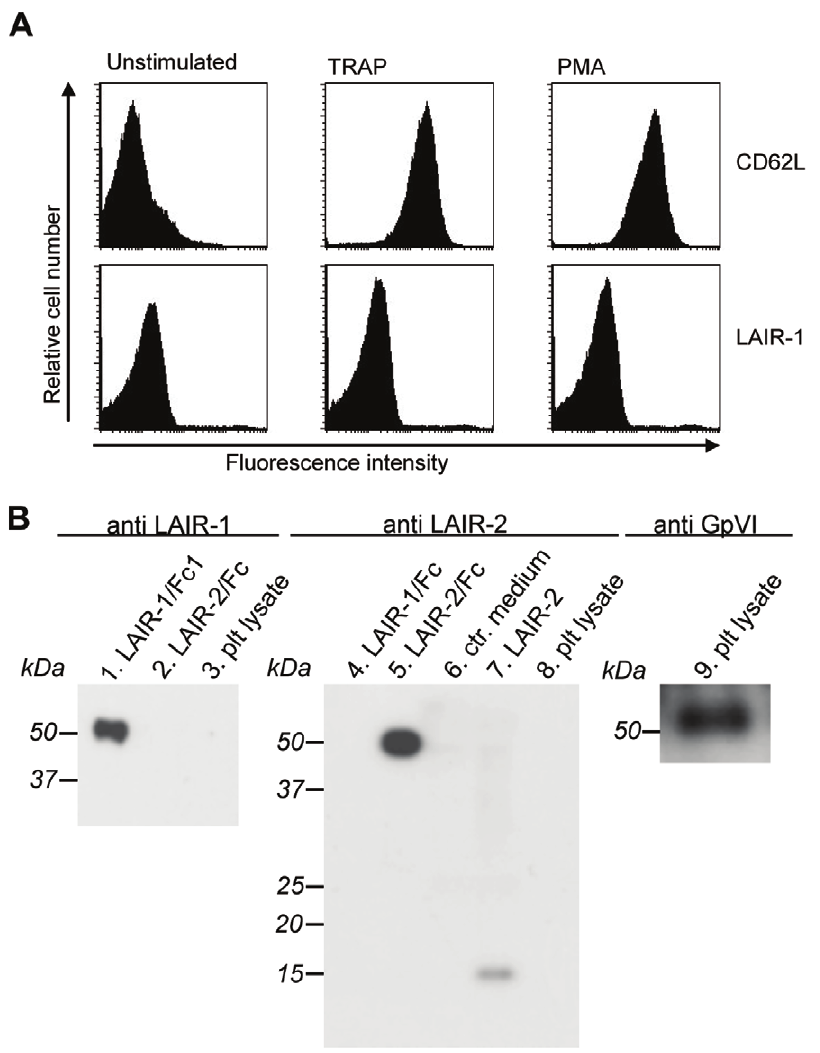
Figure 1. Platelets do not express LAIR-1 or LAIR-2. Panel A: Flowcytometric analysis of washed platelets (2 6 10E5/ m l), unstimulated or stimulated for 5 min at RT with 10 m M TRAP or 5000 nM PMA. Upper panels represent staining for CD62L, lower panels represent LAIR-1 staining. Panel B: Western blots containing whole platelet lysates and controls were incubated with antibodies against LAIR-1 ( lanes 1–3 ), LAIR-2 ( lanes 4–8 ) or GpVI ( lane 9 ). Lane 1: purified LAIR-1/Fc; lane 2: purified LAIR-2/Fc; lane 3: whole platelet lysate; lane 4: purified LAIR-1/Fc; lane 5: purified LAIR-2/Fc; lane 6: conditioned medium of non-transfected human 293T cells; lane 7: conditioned medium of human 293T cells secreting LAIR-2; lane 8: whole platelet lysate; lane 9: whole platelet lysate.